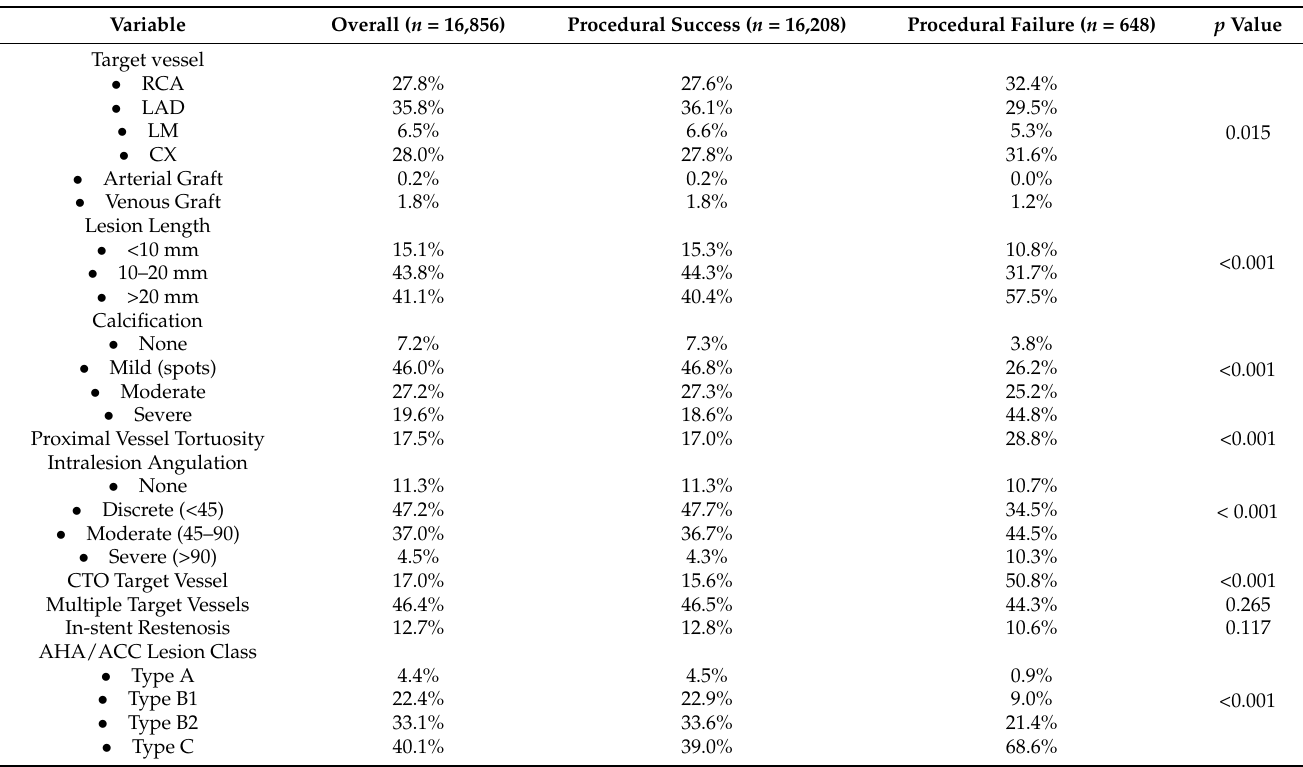
Table 2. Angiographic characteristics of patients undergoing percutaneous coronary intervention (PCI) for stable coronary artery disease (CAD) categorized according to procedural outcomes.